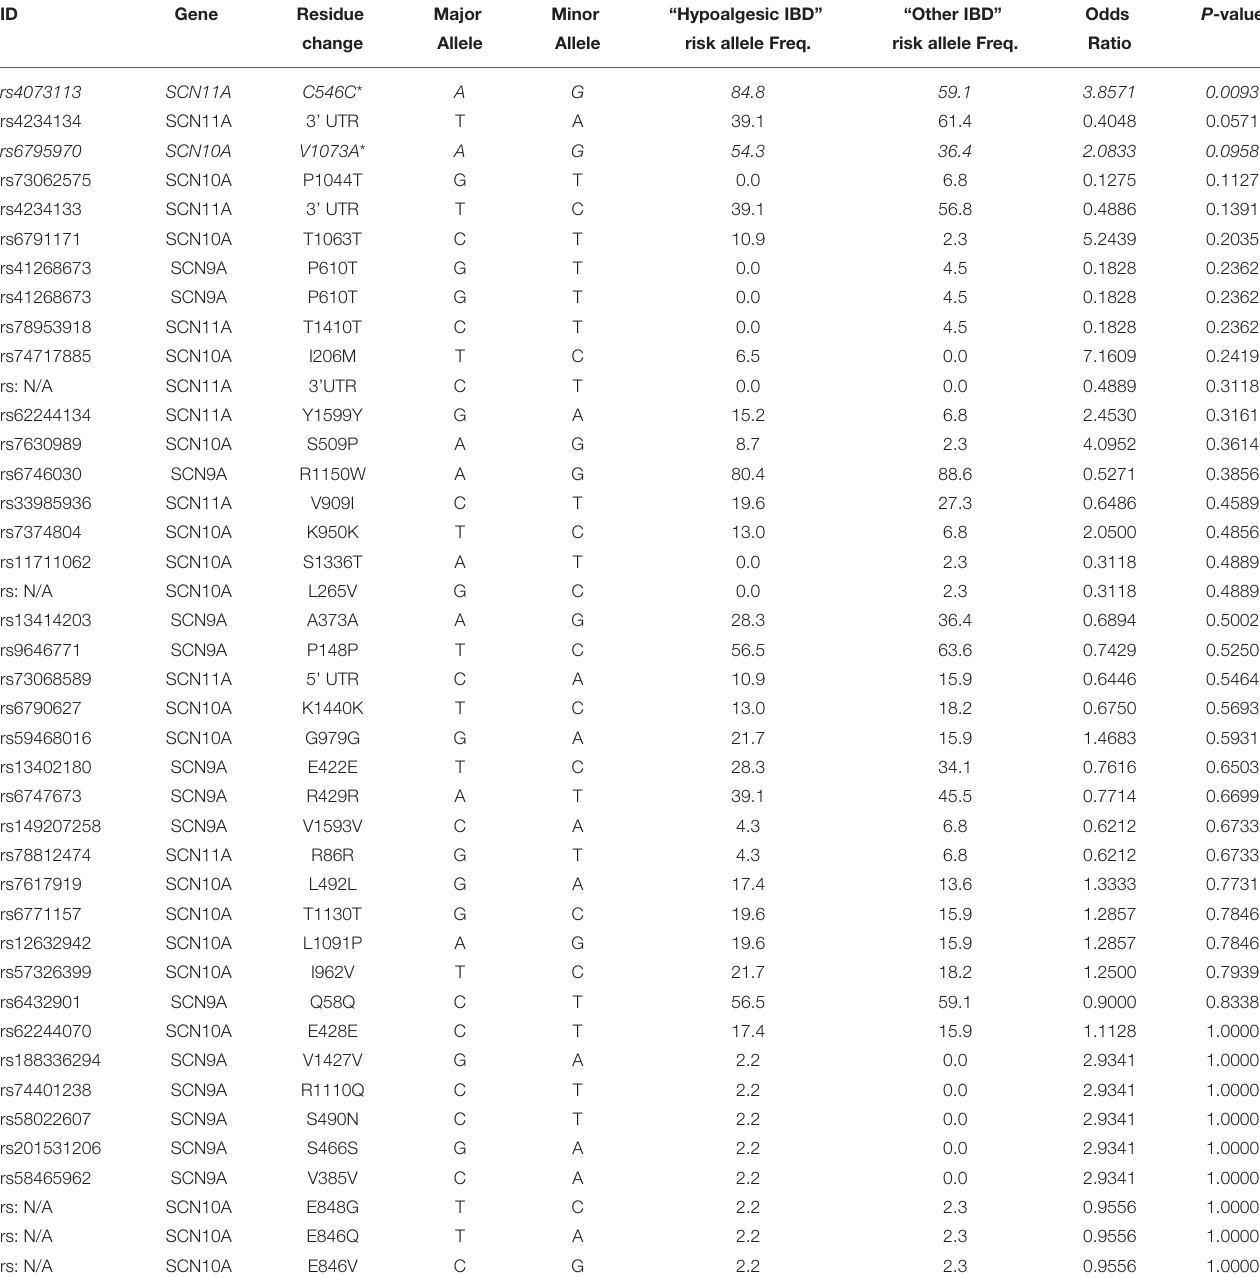
TABLE 3 | Relative frequency of SCN9A, SCN10A, and SCN11A SNPs in “Hypoalgesic IBD” compared to other IBD